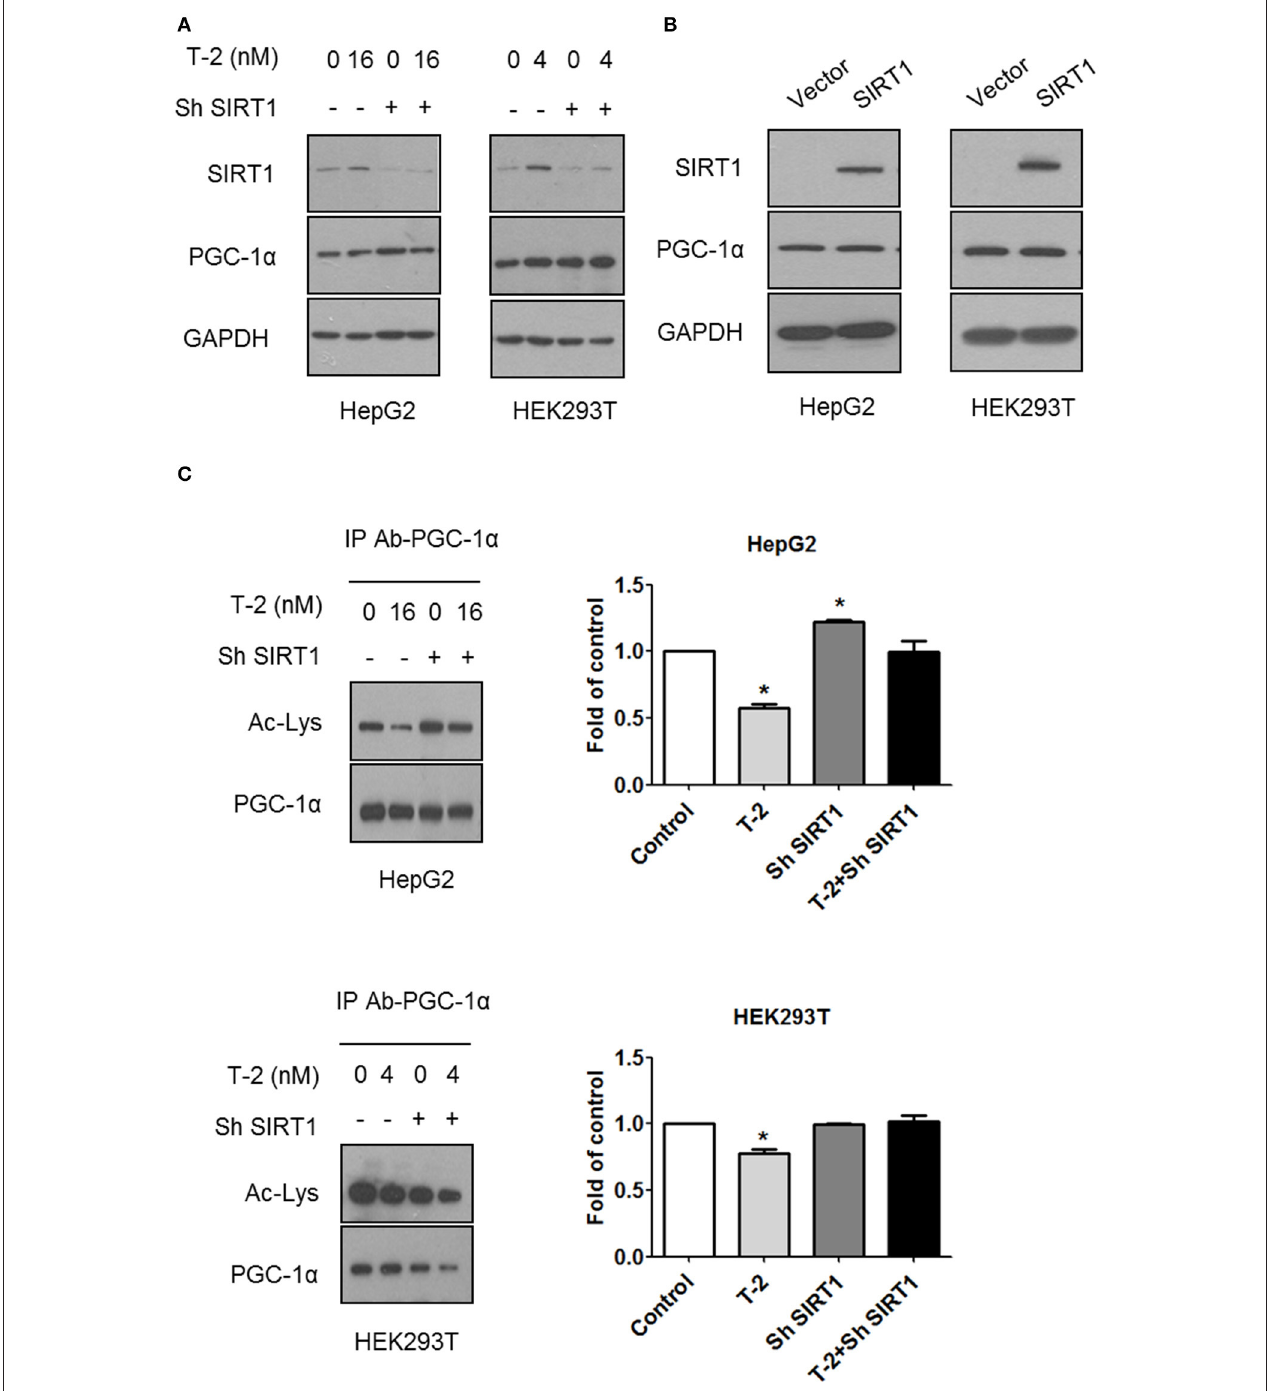
FIGURE 4 | T-2 toxin induced PGC-1 α deacetylation through SIRT1. (A) Representative immunoblot of SIRT1, PGC-1 α , and GAPDH in T-2 toxin-treated cells stably transfected with SIRT1-specific shRNA or nontargeting shRNA. (B) Representative immunoblot of SIRT1, PGC-1 α , and GAPDH in HepG2 and HEK293T cells overexpressing SIRT1. (C) HepG2 and HEK293T cells infected with SIRT1 or nontargeting shRNA were treated with T-2 toxin, and PGC-1 α acetylation was tested by immunoprecipitation with an anti-PGC-1 α antibody, followed by immunoblot analysis with the antibody specific to acetylated lysine. The data are expressed as fold values for three separate experiments. Statistically significant differences are indicated by asterisks (* P < 0.05).